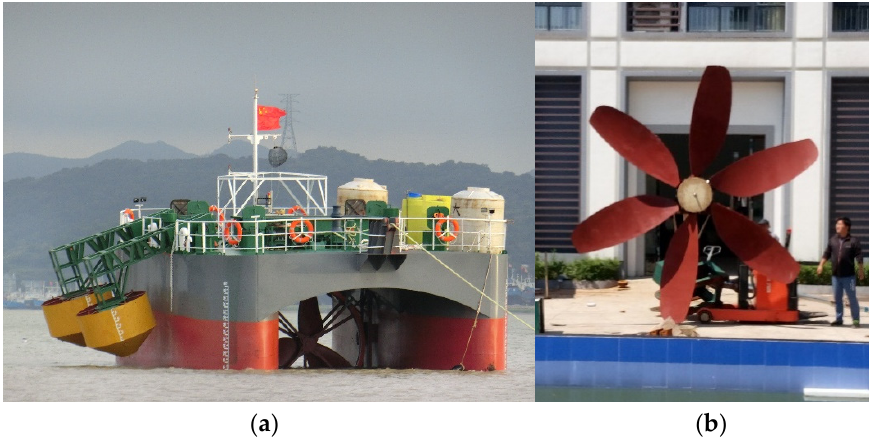
Figure 10. Physical image of sea trial: ( a ) Physical image of ocean power generation platform, ( b ) Physical image of thin-walled airfoil turbine. Table 7. Basic parameters of ocean power-generation